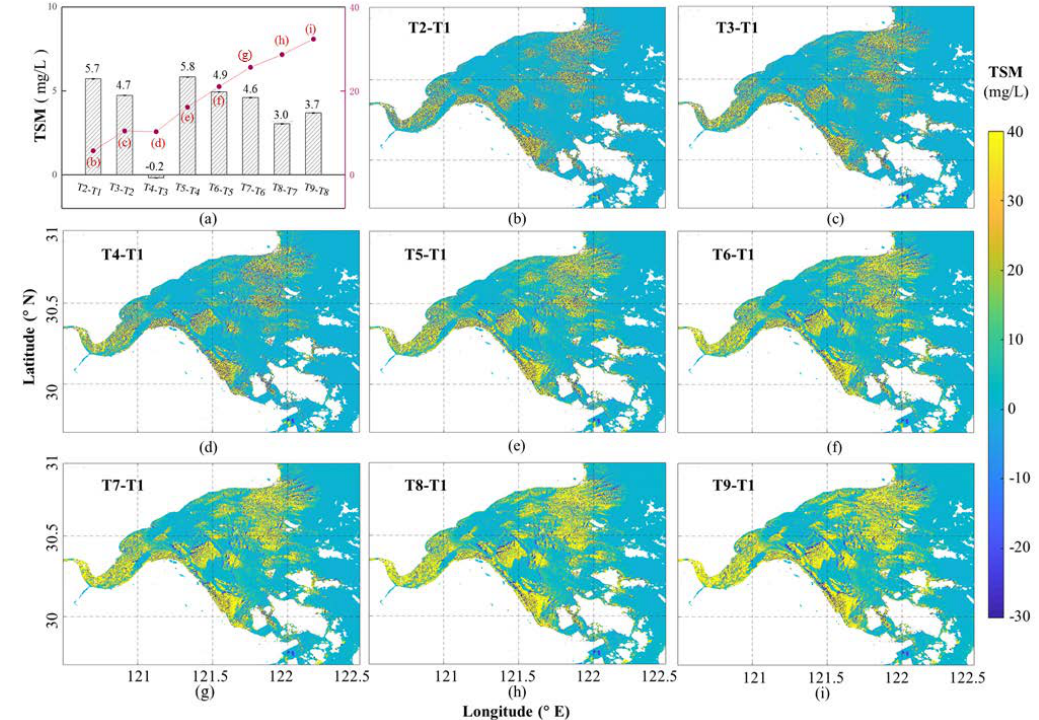
Figure 6. The minute variations of TSM concentration in HZB. ( a ) The bar shows the average TSM concentration difference per minute, and the red dotted line shows the cumulative average TSM concentration difference per minute. ( b – i ) shows the spatial distribution of the cumulative average TSM concentration difference per